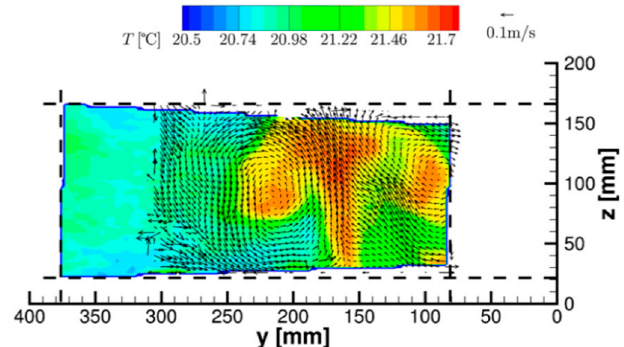
Figure 12. Instantaneous temperature contours and velocity vectors in a vertical plane over the heated wall of a cuboidal convection sample, from Schmeling et al. [89]. For the sake of clarity, only every second vector is shown in each direction. Recorded for a Prandtl number Pr = 0.71, a Reynolds number Re = 0 and a Rayleigh number Ra = 9 × 10 7 . Reprinted by permission from Ref. [89], Measurement Science and Technology, Copyright © 2022 IOP Publishing Ltd.